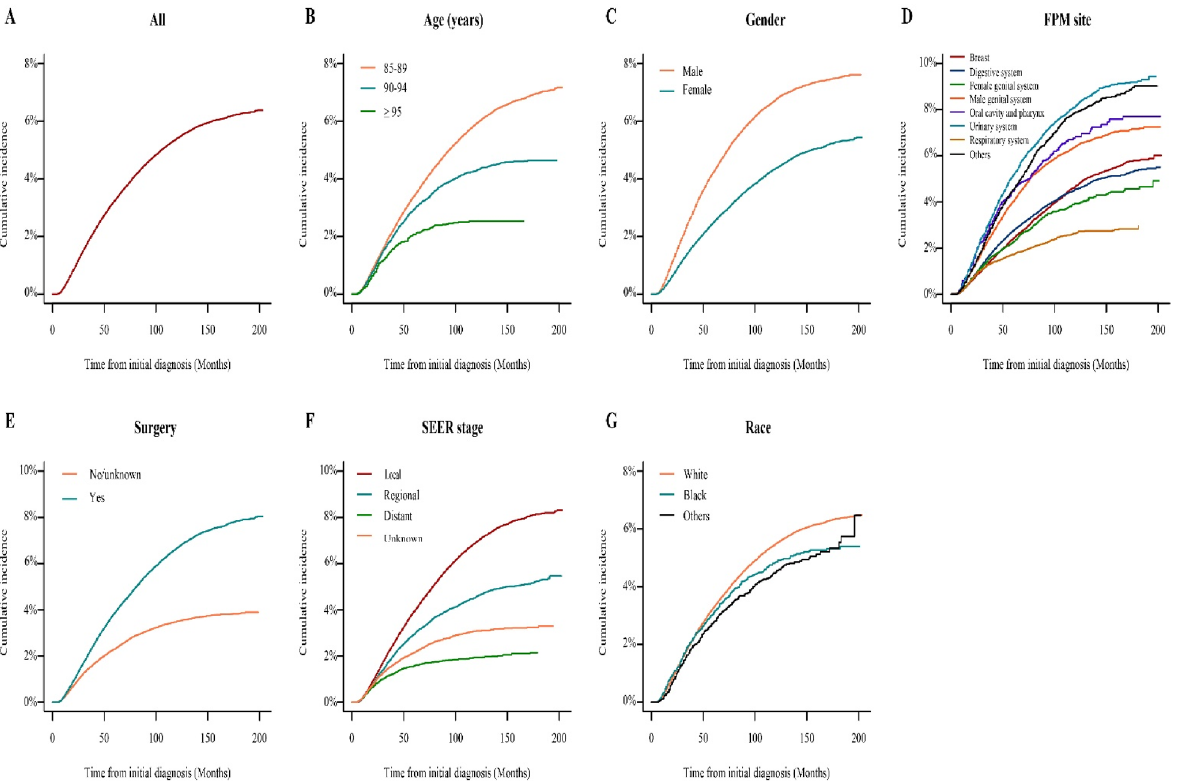
Figure 1. Cumulative incidence of ( A ) all and stratified by ( B ) age, ( C ) gender, ( D ) FPM site, ( E ) surgery history, ( F ) SEER stage, and ( G ) race. FPM, first primary malignancy; SEER surveillance, epidemiology, and end